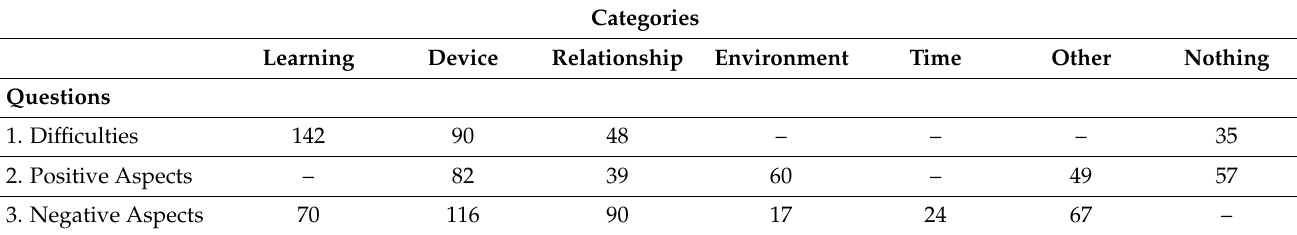
Table 2. Categories based on responses to each